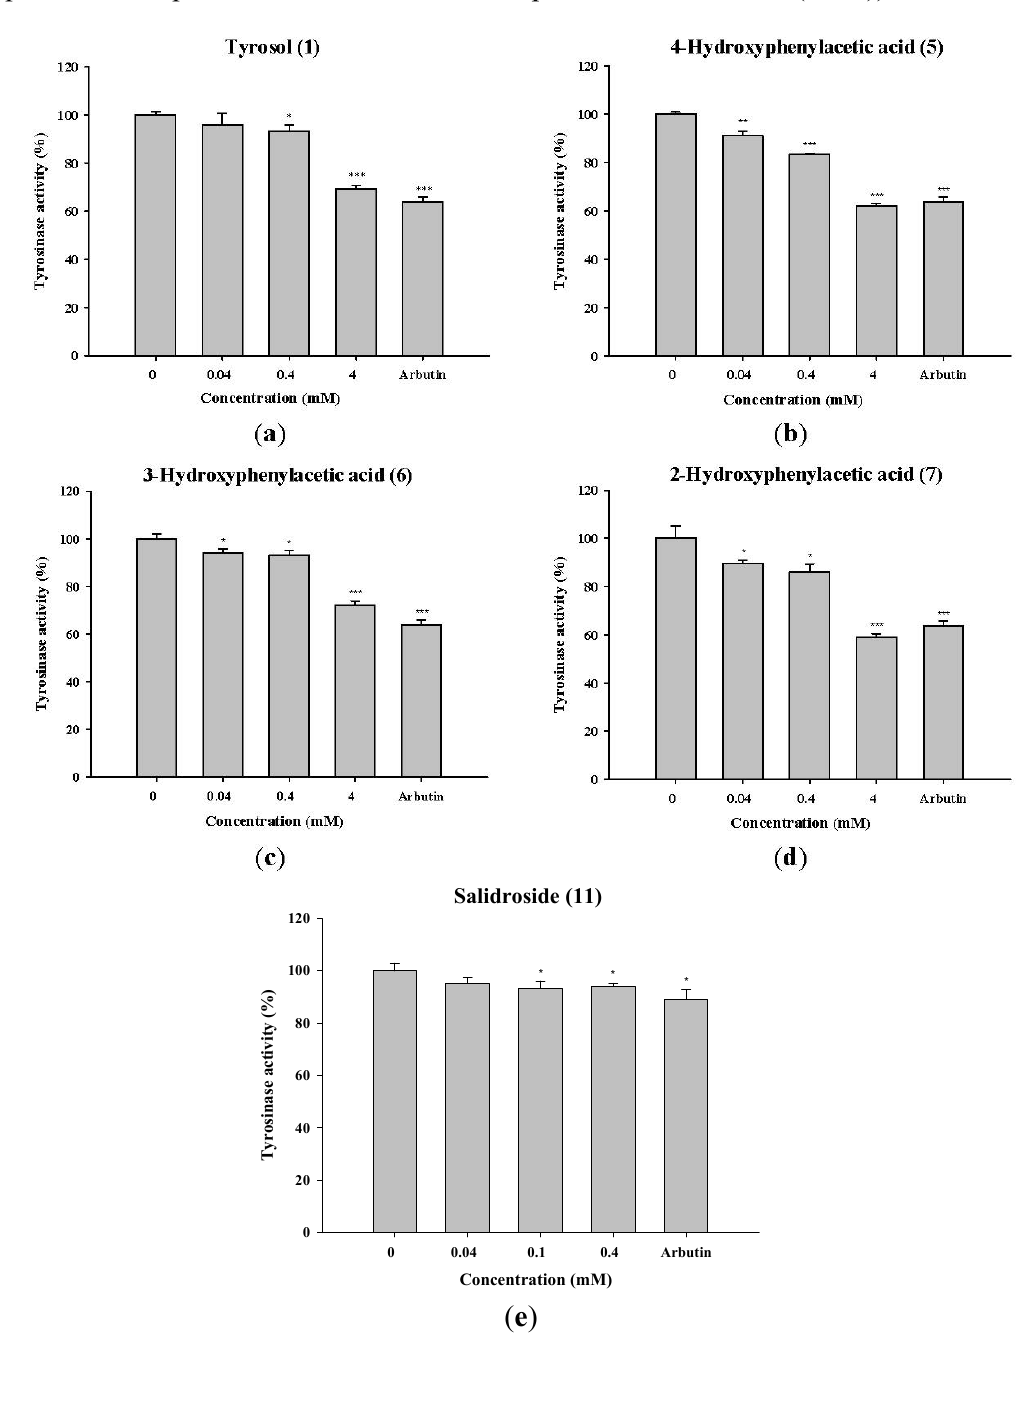
Figure 5. Tyrosinase activity (%) in B16F0 cells exposed to ( a ) tyrosol ( 1 ); ( b ) 4-hydroxyphenylacetic acid (4-HA) ( 5 ); ( c ) 3-hydroxyphenylacetic acid (3-HA) ( 6 ); ( d ) 2-hydroxyphenylacetic acid (2-HA) ( 7 ) and ( e ) salidroside ( 11 ). ( * p <